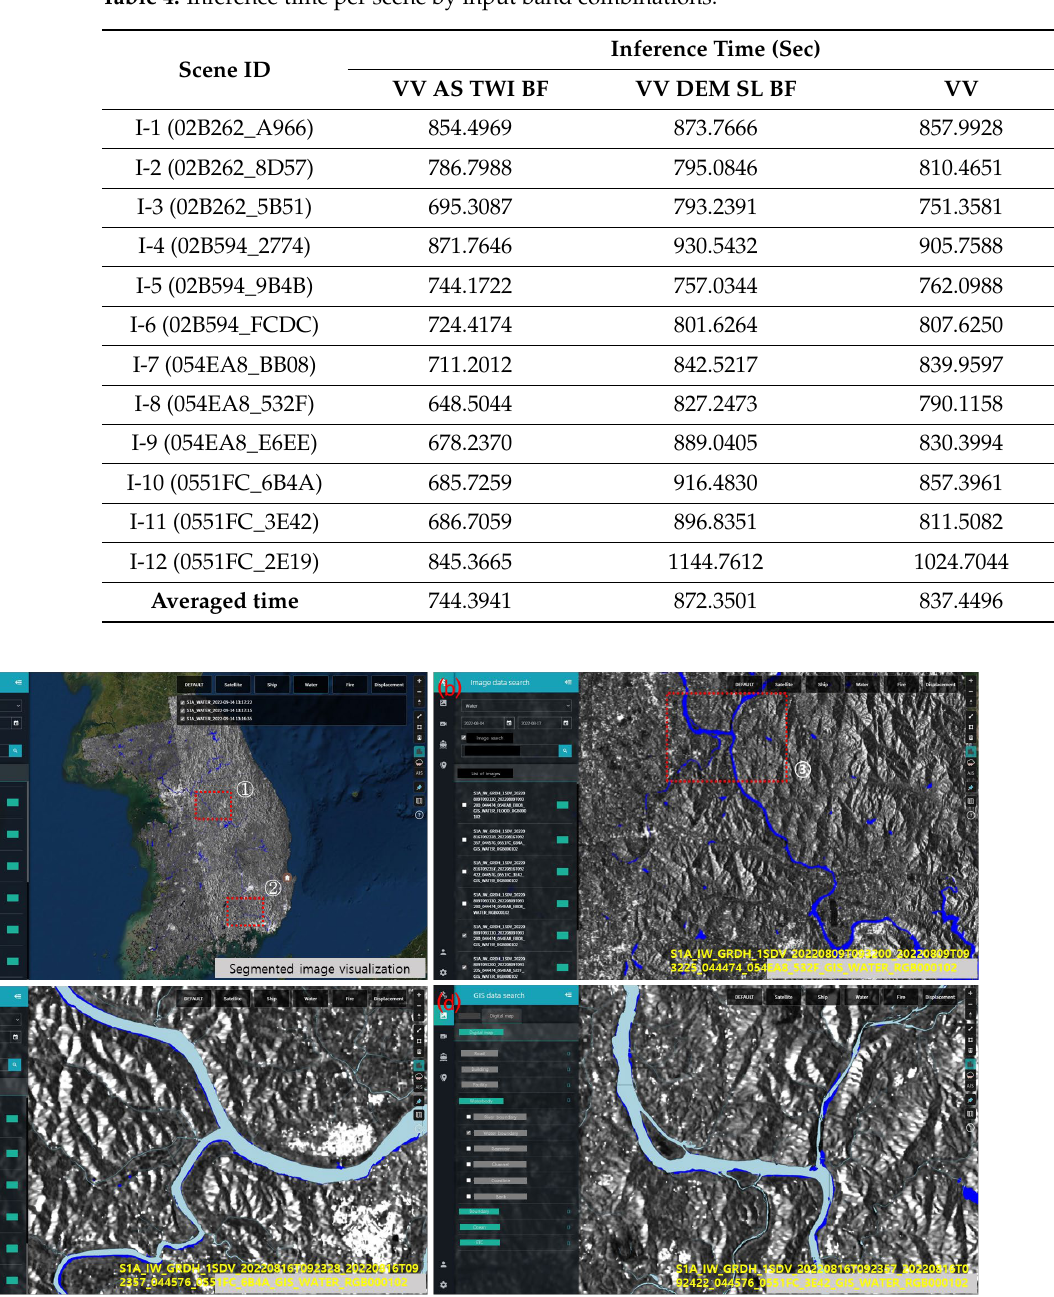
Table 4. Inference time per scene by input band combinations.